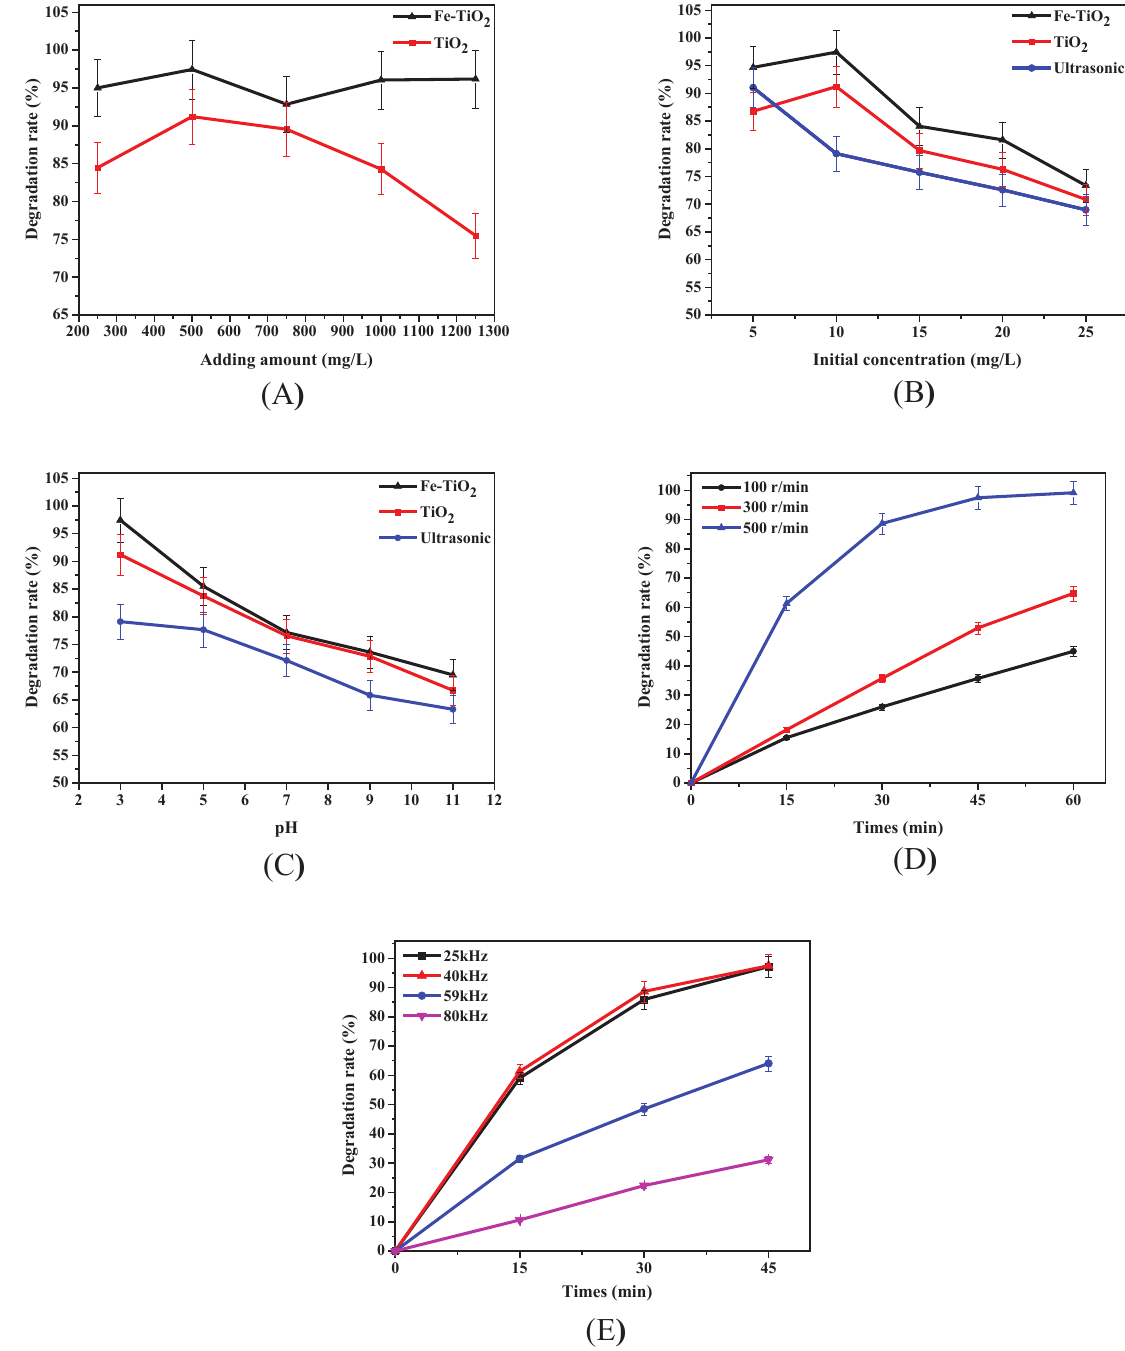
Figure 7: Effect of (A) TiO 2 added amount, (B) initial concentration, (C) pH, (D) revolutions per minute and (E) ultrasonic frequency on sonocatalytic degradation of methyl orange.